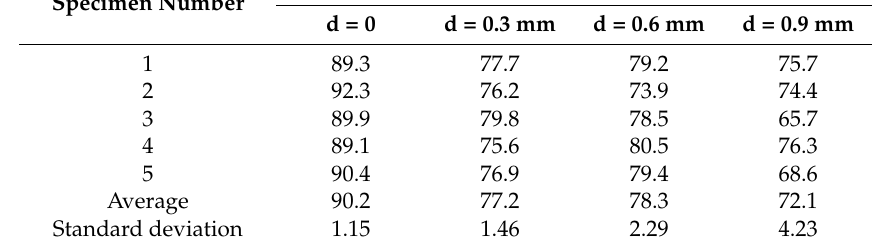
Table 4. Apparent interlaminar shear strength of unpinned Cf/Al composites and z-pinned Cf/Al composites using stainless steel pins with a volume fraction of 1% measured/determined by short-beam shear test.